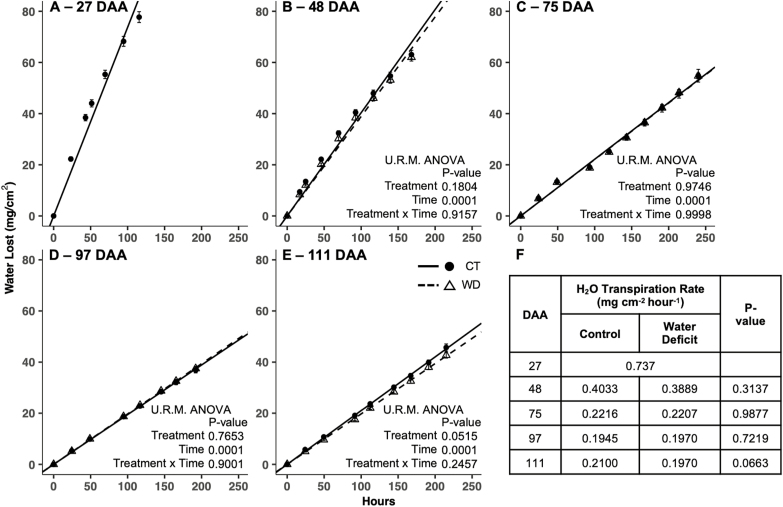
Rates of water transpiration of the whole berry at different stages of development in grapevines (Vitis vinifera L.) exposed to two irrigation treatments: well-irrigated (control, CT) and deficit irrigated (water deficit, WD). Stages of development that were measured were 27 (A), 48 (B), 75 (C), 97 (D), and 111 (E) days after anthesis (DAA). Error bars represent ±SE; significant differences in the cumulative amount of water lost for each developmental stage were determined by univariate repeated measures ANOVA (U.R.M. ANOVA). The effects of treatment, time, and their interaction are reported. In the table (F), the average transpiration rate and the significance value of the t-test at each developmental stage are reported.